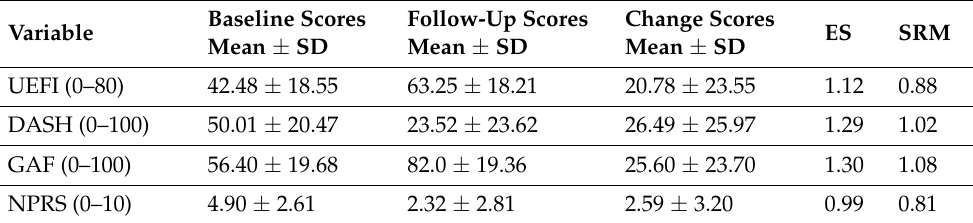
Table 2. Outcome measures at baseline and follow-up ( N = 63).